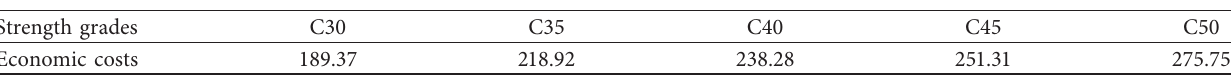
Table 7: Cost of different strength grades coal gangue-based geopolymer concrete based on traditional GSA (yuan/m 3 ).